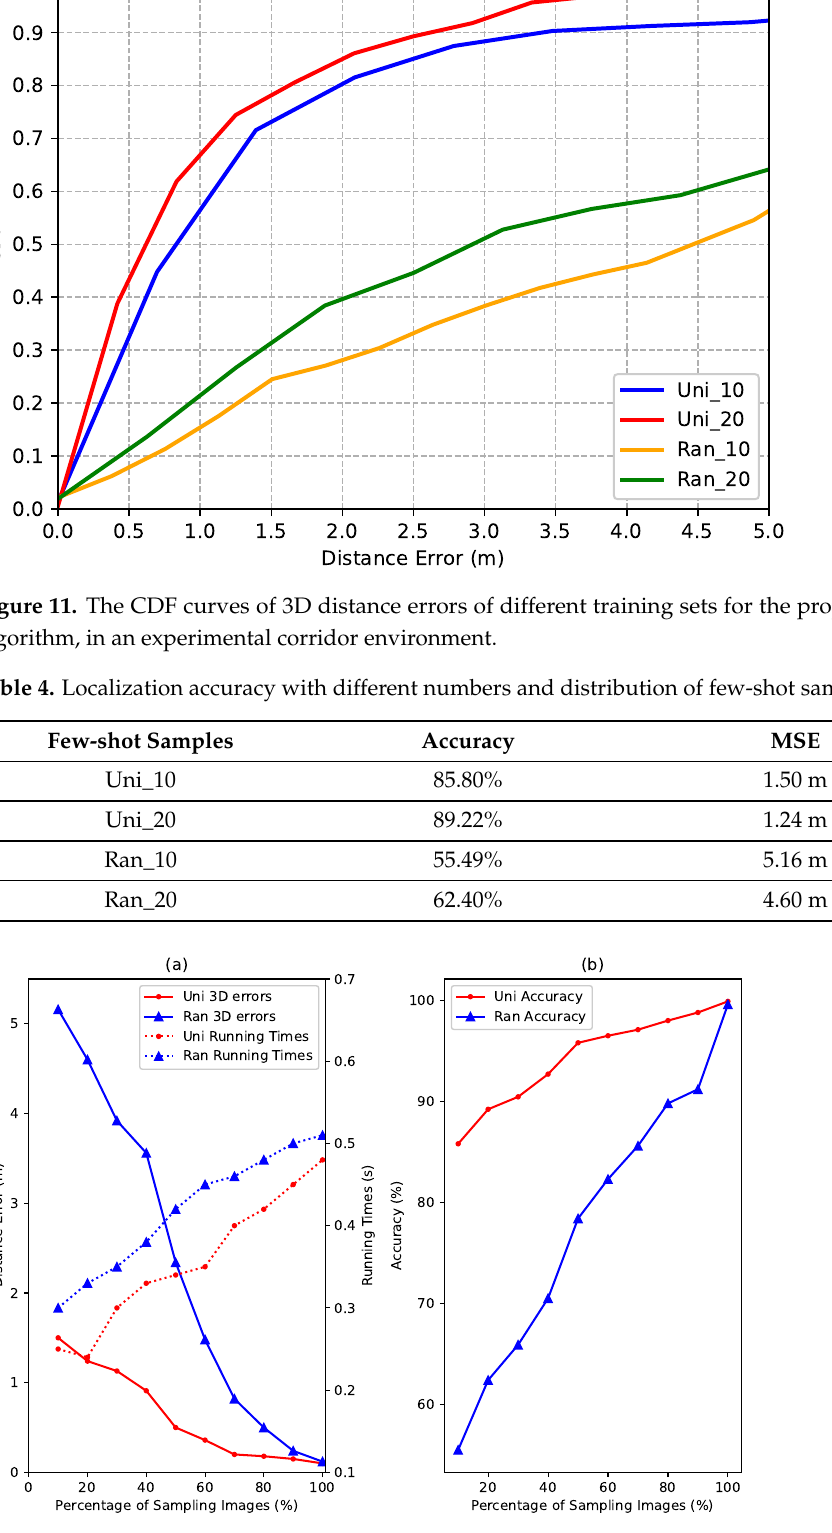
Figure 12. Influences of distribution of few-shot samples in our experiments. ( a ) represent results for localization distance error and average time consumption for different few-shot sample distributions. ( b ) shows results for the estimation accuracy of floors for different distributions of few-shot